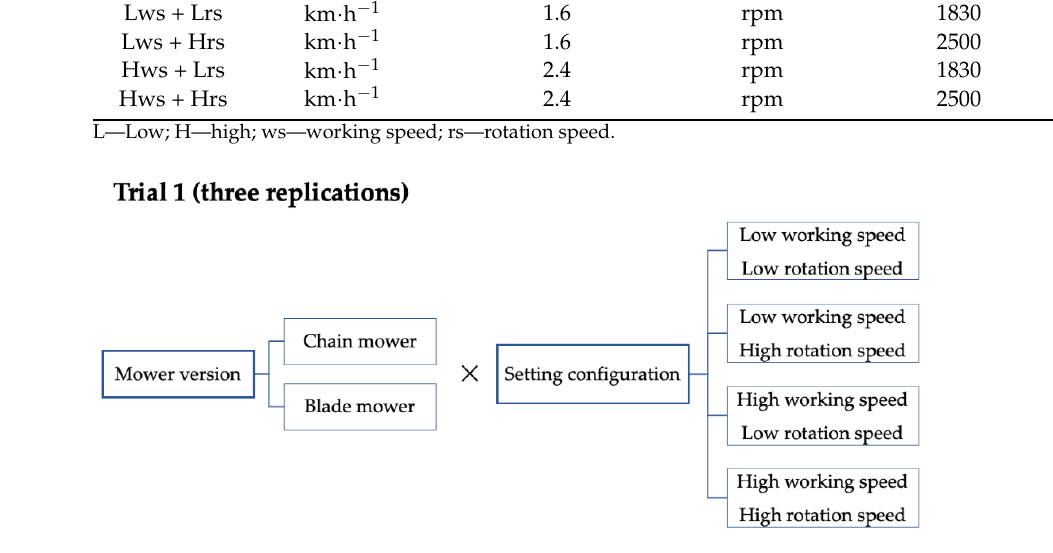
Figure 3. Diagram describing tested factors and relative levels in the first trial.